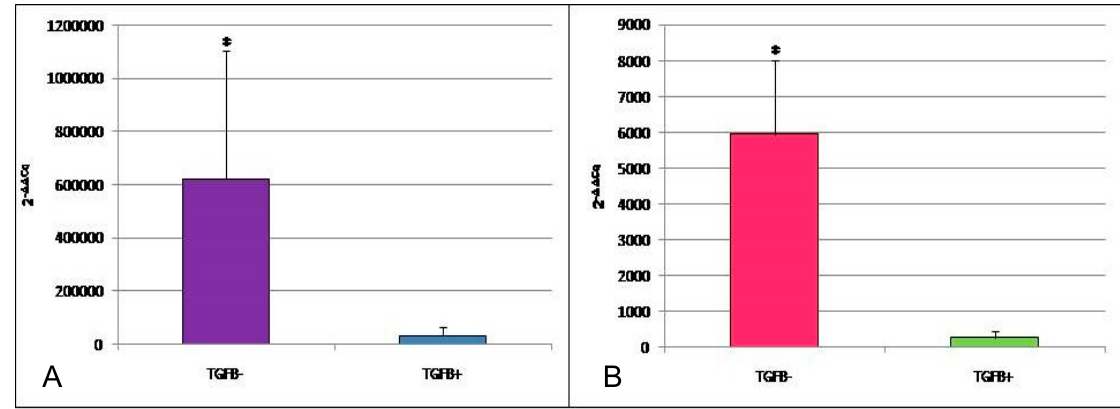
Figure 3. A : IFNG expression in equine penile tumor samples. B : IL2 expression in equine penile tumor samples. Data are expressed as 2 − ∆∆ Cq where ∆ Cq = Cq (target gene) − Cq (reference gene); values are the mean of three test replicates ± 1 standard deviation and ∆∆ Cq = ∆ Cq (samples TGFB + ) − ∆ Cq (samples TGFB − ). Negative samples were given a Cq 48 fictitious value. * p < 0.05.